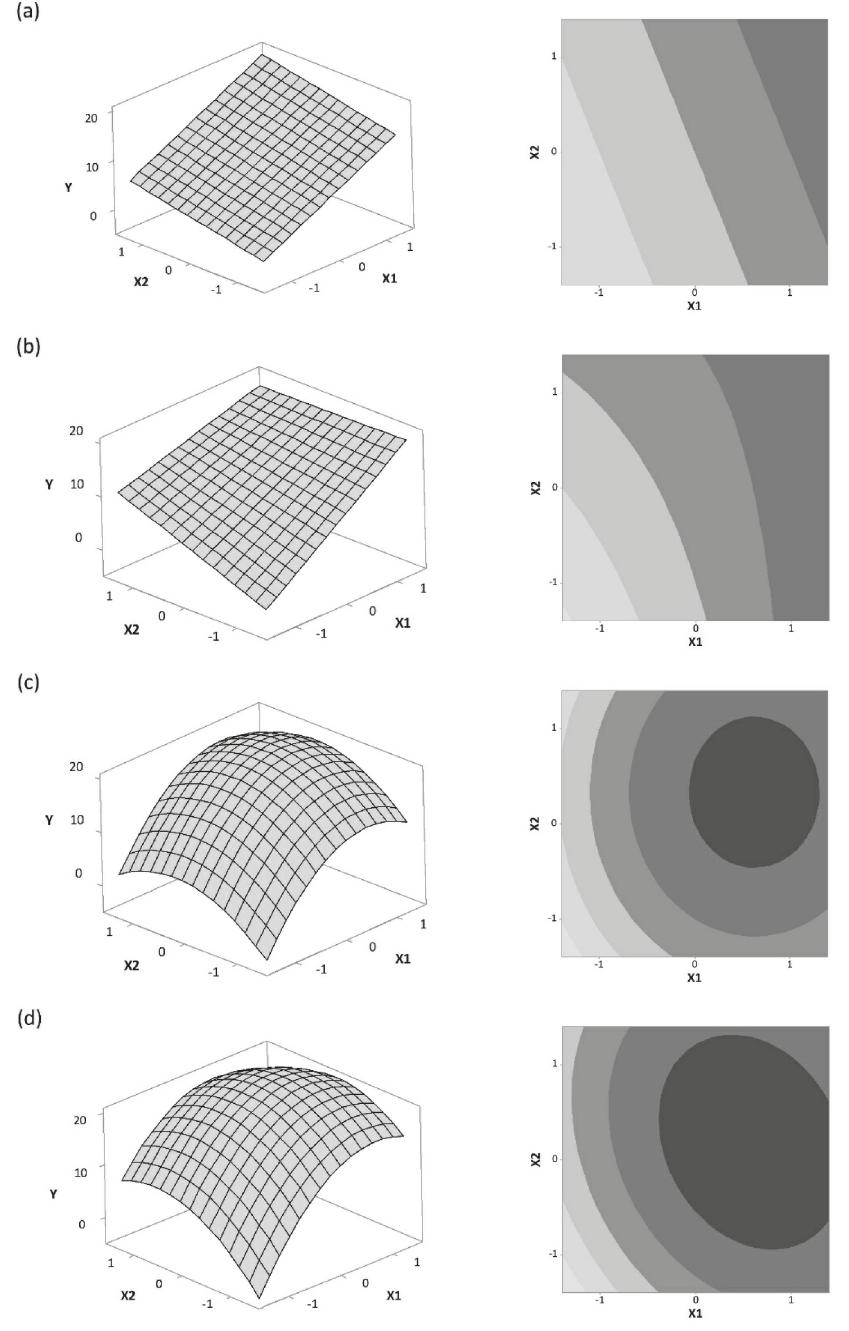
FIGURE 6 – Response surface and counter plots for linear (a), linear + interaction (b), linear + quadratic, and full (d) model